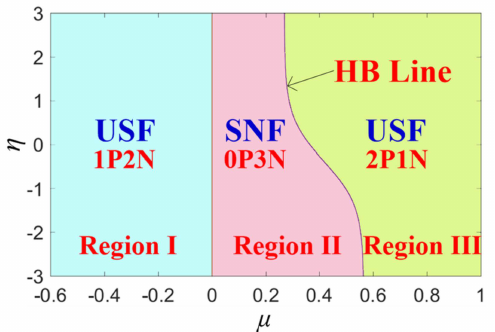
Figure 5. For the three non-zero roots, the stability distribution in the µ – η plane, where k 1 = 1 and k 2 =